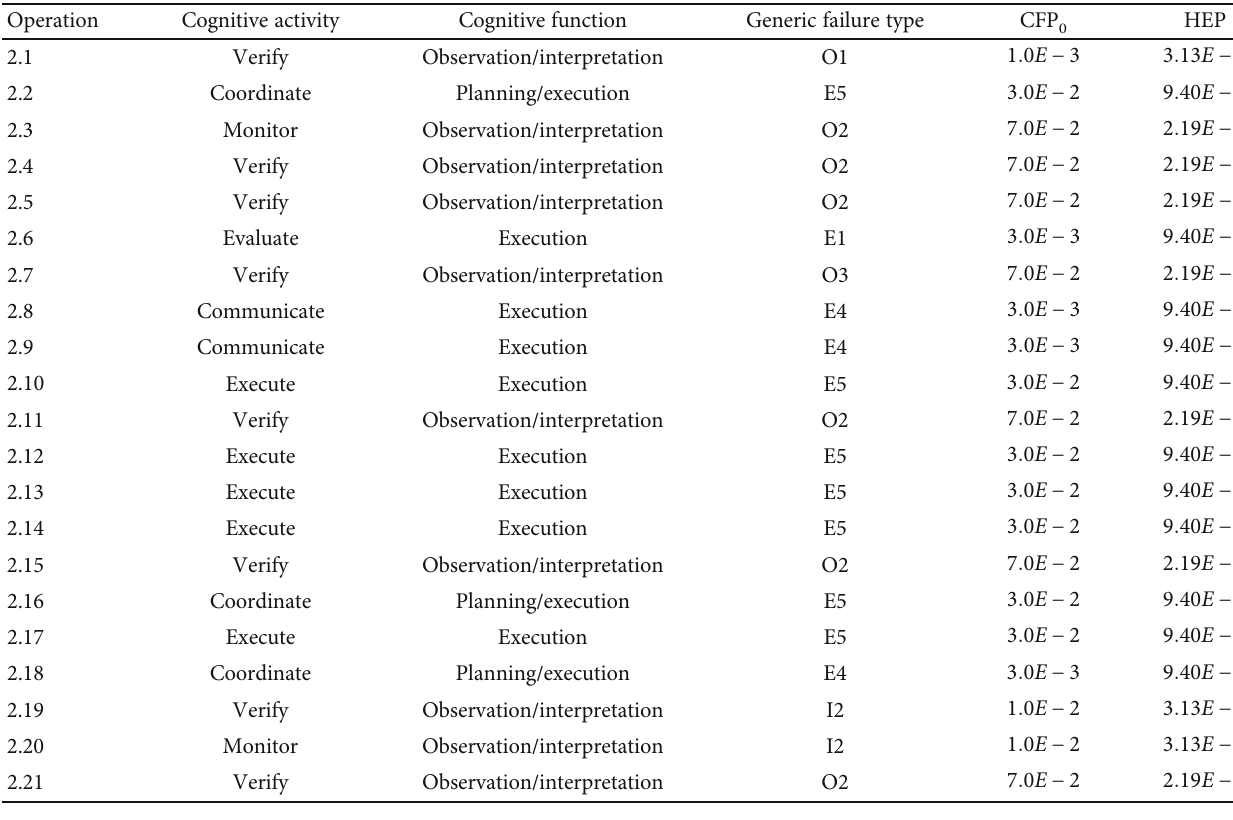
Table 10: HEPs for landing operations.